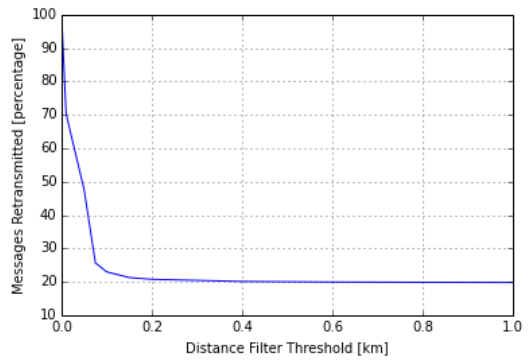
Figure 5. Messages retransmitted after distance filter implemented.